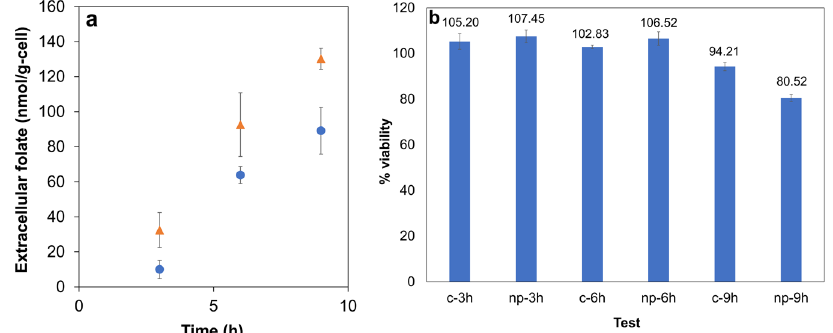
Fig. 5 Effects of AgNPs on folate secretion, and role of latter in affecting HCT116 viability. ( indicates control culture; indicates culture treated with 25ppm AgNP). a The extracellular folic acid concentrations increased on exposure to AgNPs. This increase could be an outcome of the oxidative stress induced in the organism, which in turn impact folate related metabolic pathways. b MTT analysis of HCT116 treated with bacterial supernatants from cultures exposed to silver nanoparticles and control. Reduction in viability was observed for cells treated with 9th h supernatants ( p -value = 0.0031), the time point corresponding to maximum concentration. Values are expressed as mean ± SD, n =